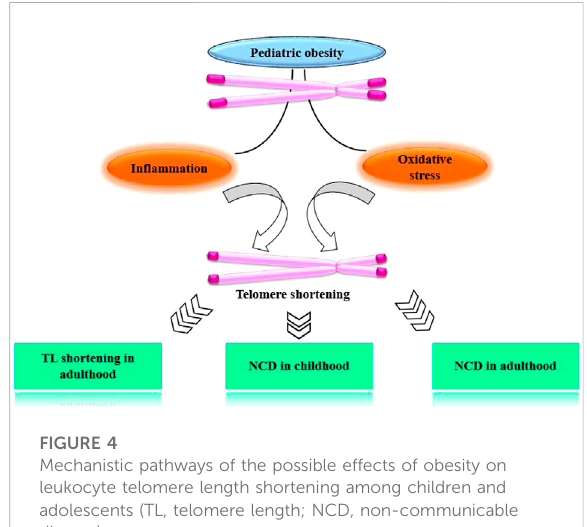
FIGURE 4 Mechanistic pathways of the possible effects of obesity on leukocyte telomere length shortening among children and adolescents (TL, telomere length; NCD, non-communicable